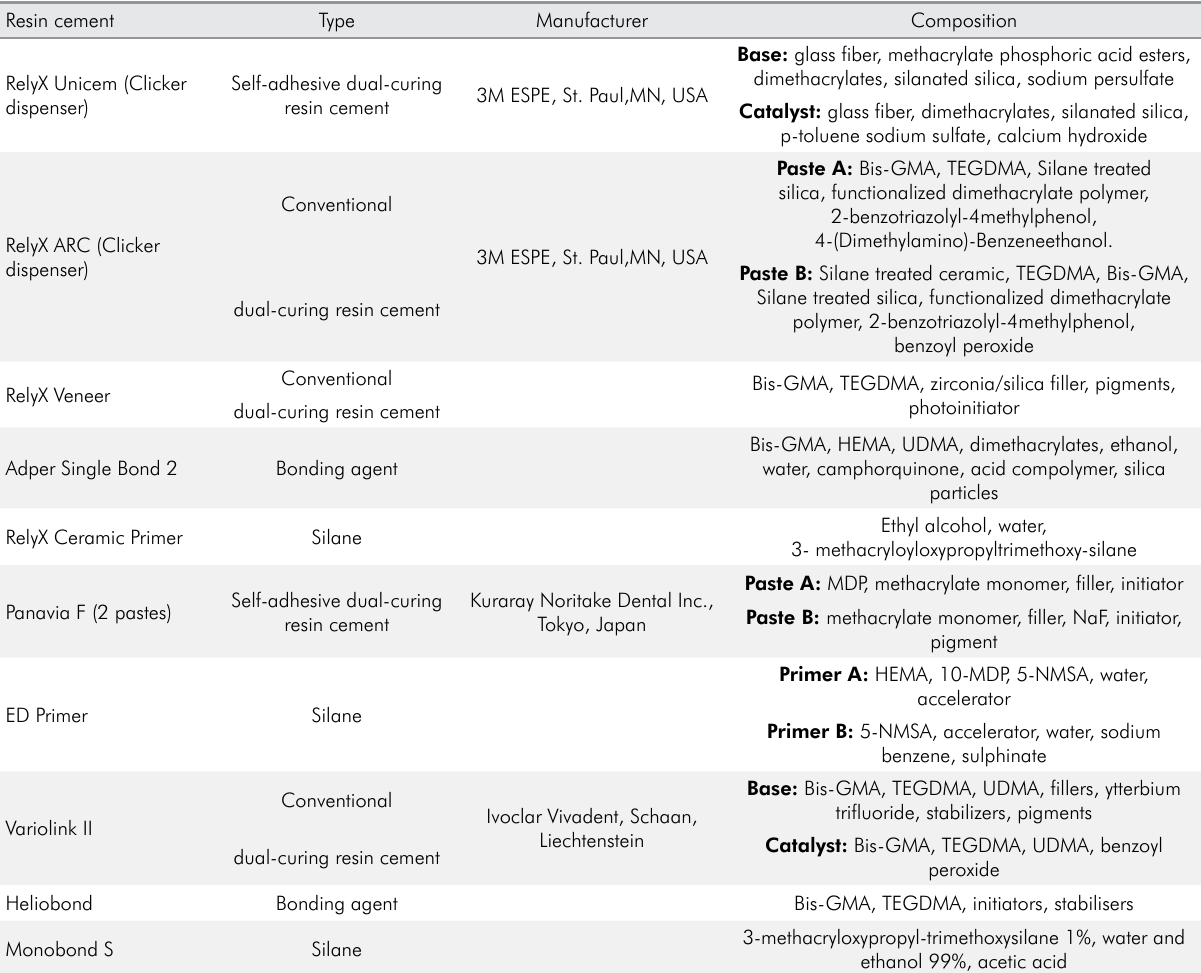
Table 1. Resin cement systems used according to manufacturer’s